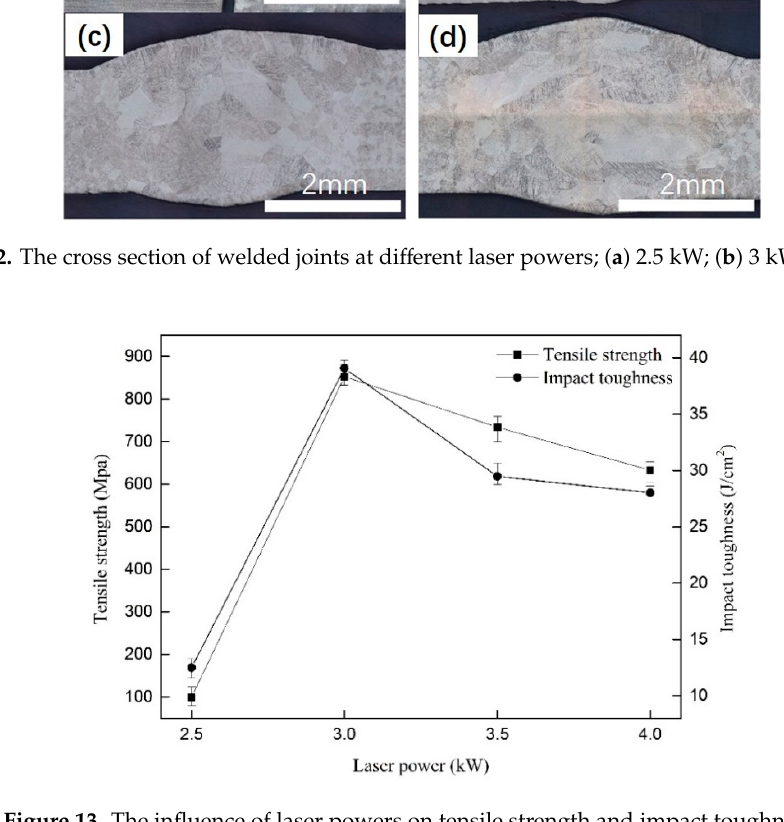
Figure 12. The cross section of welded joints at different laser powers; ( a ) 2.5 kW; ( b ) 3 kW; ( c ) 3.5 kW; ( d ) 4 kW.